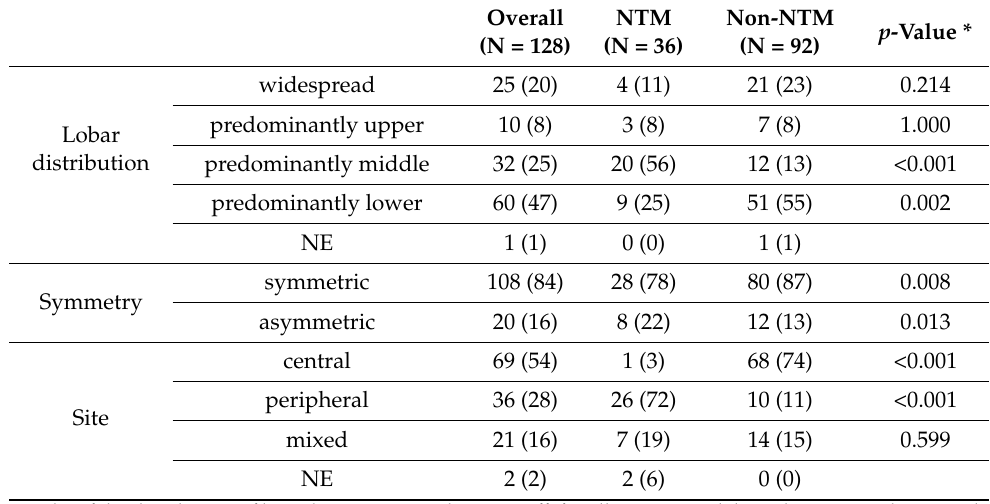
Table 3. Results of the distribution of bronchiectasis.